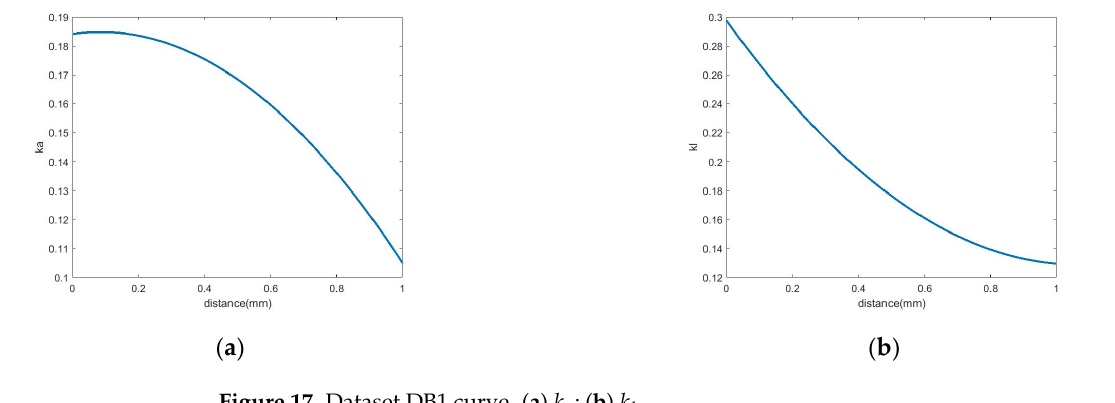
Figure 17. Dataset DB1 curve. ( a ) k a ; ( b ) k l